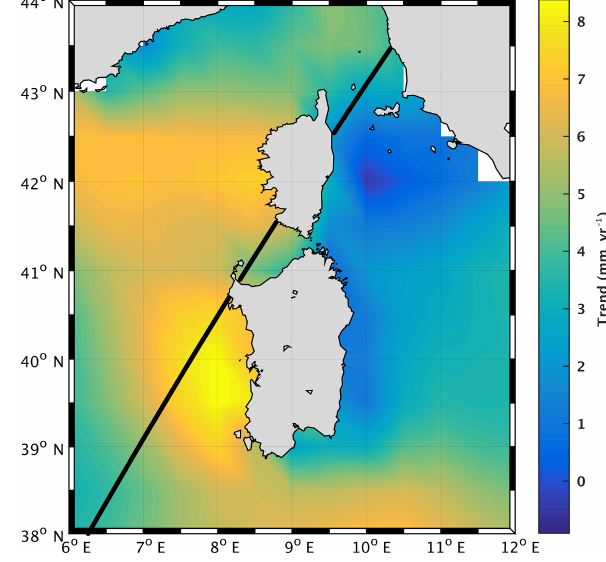
Figure 14. Wave height trends (in mmyr − 1 ) over 2002–2016 in the western Mediterranean Sea (data from ERA5